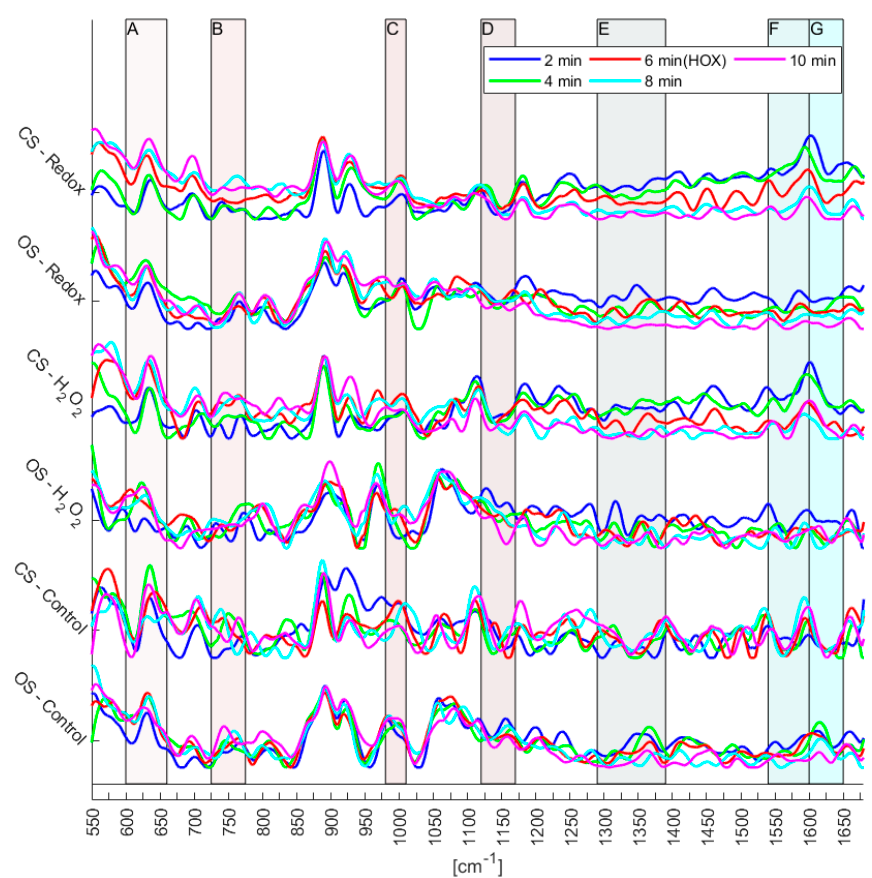
Figure 6. Stacked processed time series of Raman spectra from each experiment—Redox, H 2 O 2 and control—in the closed system (CS) and open system (OS).